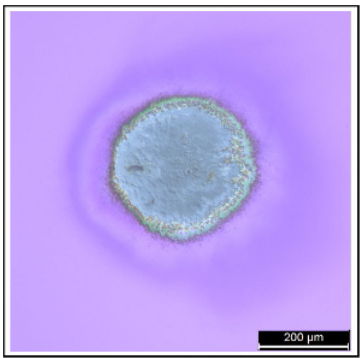
Fig. 1 DIC microscopy image of the investigated damage site (see also Fig. 4) of the Ta 2 O 5 coated sample. The site was